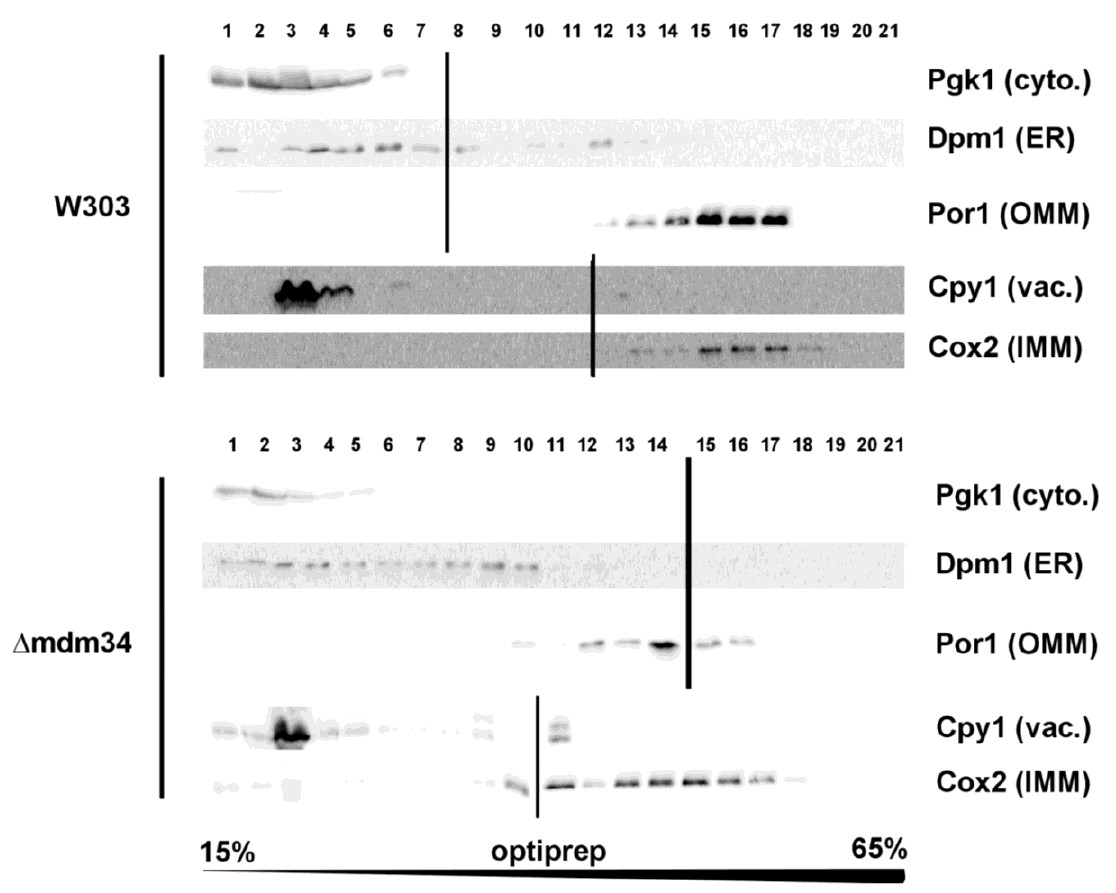
FIGURE 1: The deletion of MDM34 destabilizes MAMs. Cell extracts were separated on a 15-65% gradient of Optiprep. The gradient was resolved into 21 fractions and analyzed by western-blot for the presence of indicated markers. Vertical lines separate different gels. Data shown are from extracts obtained at the same time for each strain, and are representative of four independent